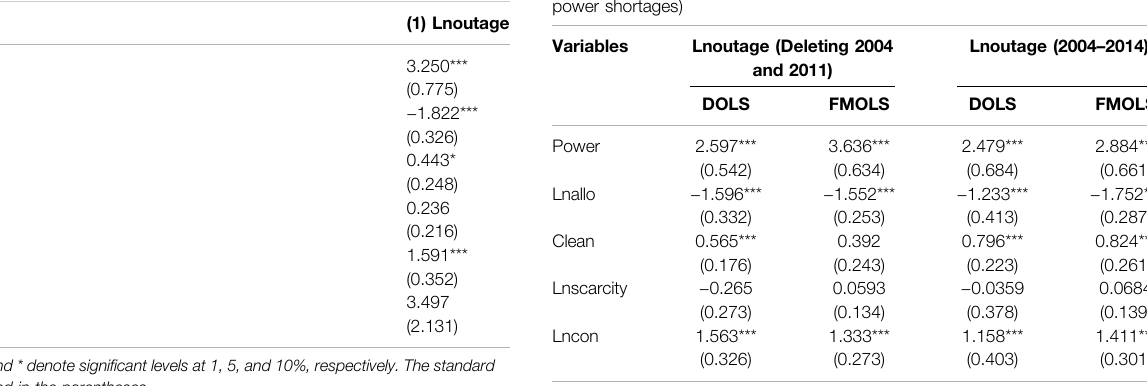
TABLE 8 | Robustness tests (under considering electricity reform and large-scale power